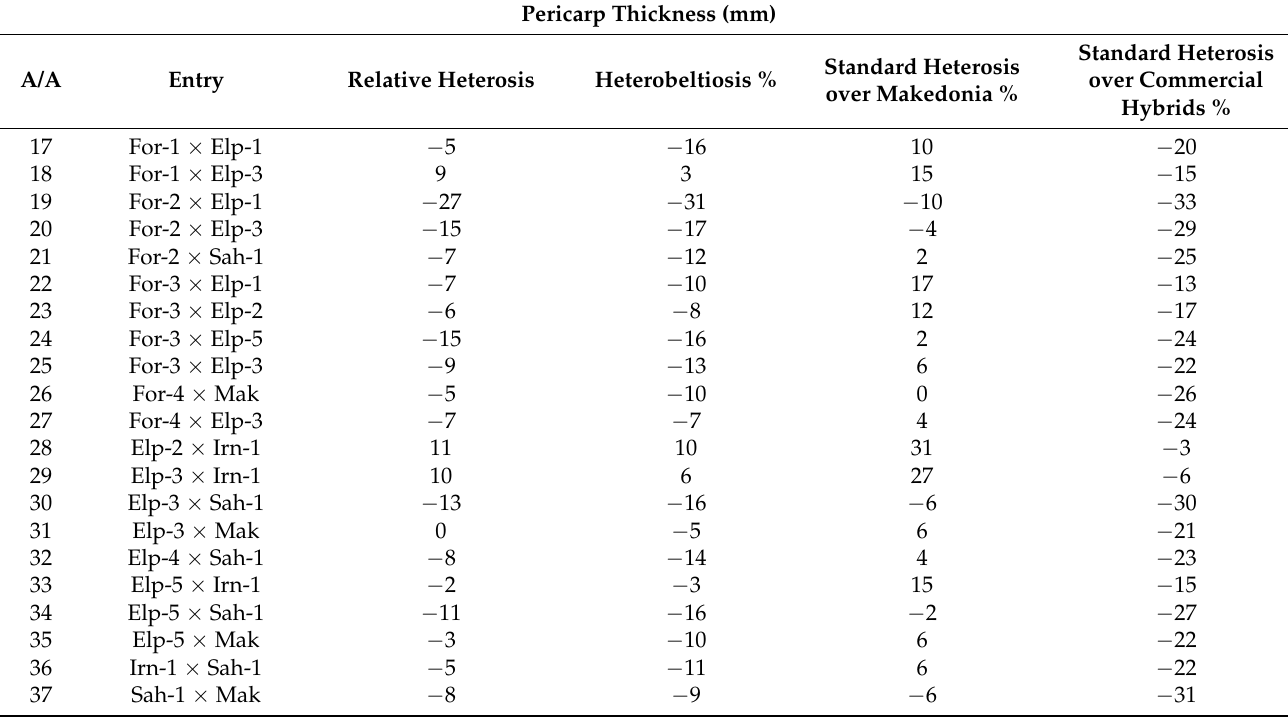
Table 10. Relative heterosis, heterobeltiosis, and standard heterosis of the original commercial hybrids, the new recombinant inbred lines, and the reconstructed new hybrids, as for pericarp thickness (mm).